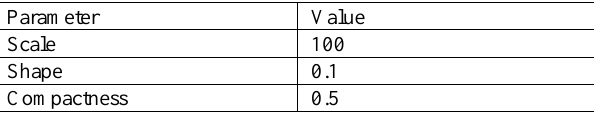
Table 2. Segmentation parameters for the MRS process in